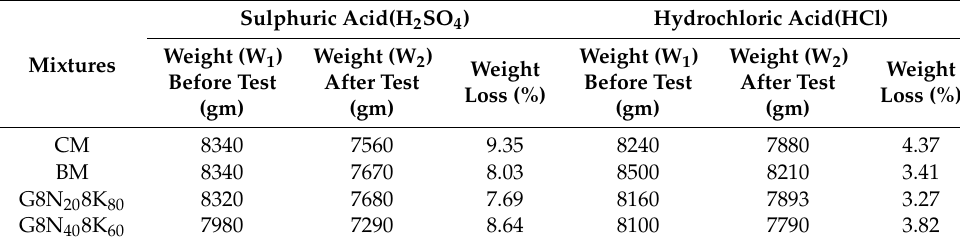
Table 9. Residual weight loss calculation after acid attack